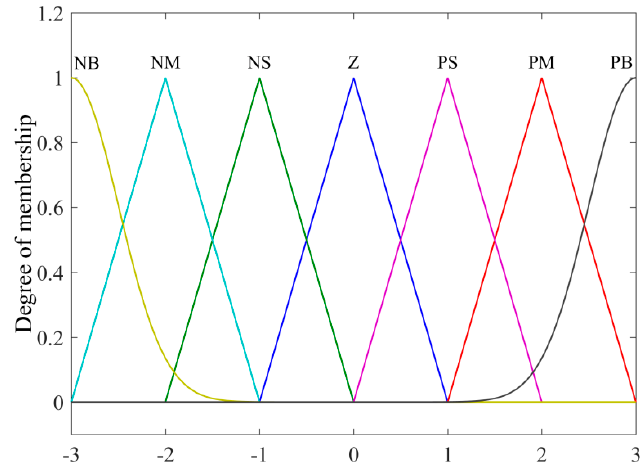
Figure 7. Membership functions of the speed deviation, the change rate of the speed deviation, the increment of the proportional coefficient, the increment of the integral coefficient and the increment of the differential coefficient.